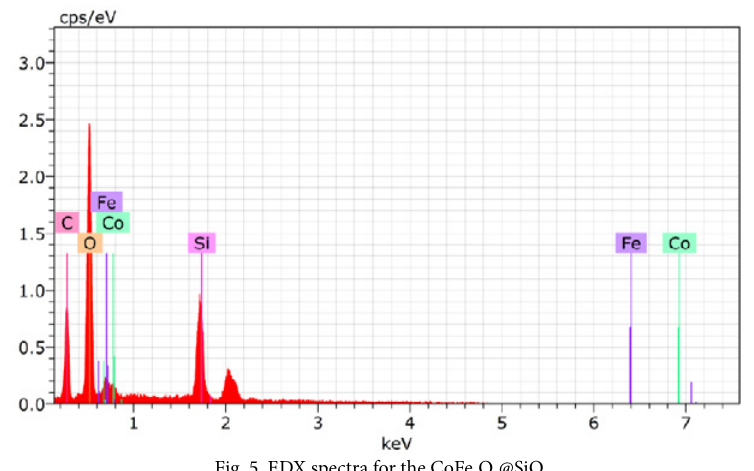
Fig. 5. EDX spectra for the CoFe Figure 5: EDX spectra for the CoFe 2 O 4 @SiO 2